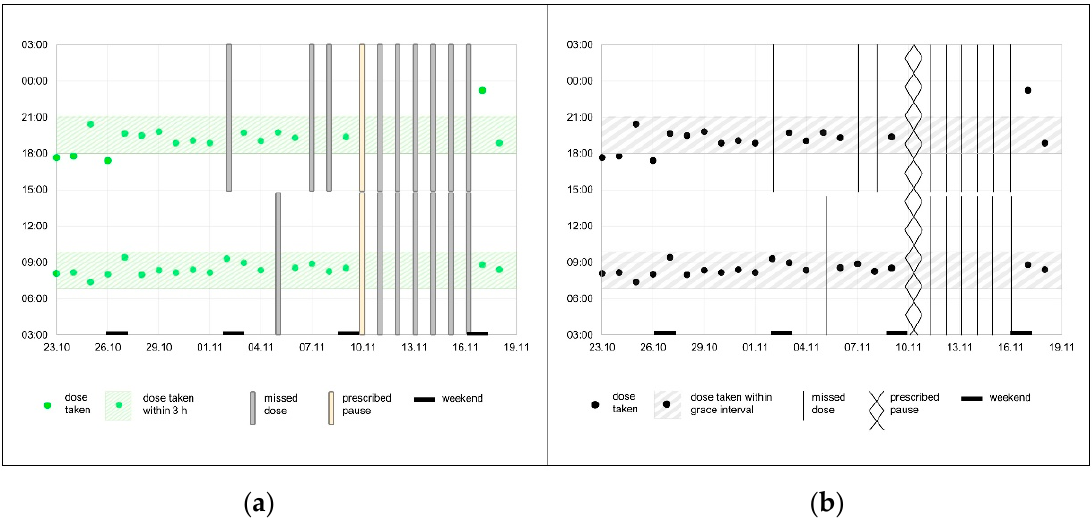
Figure 5. Two dot charts with electronic monitoring data (see Figure 2): ( a ) first draft after the physician panel, ( b ) after physician feedback.